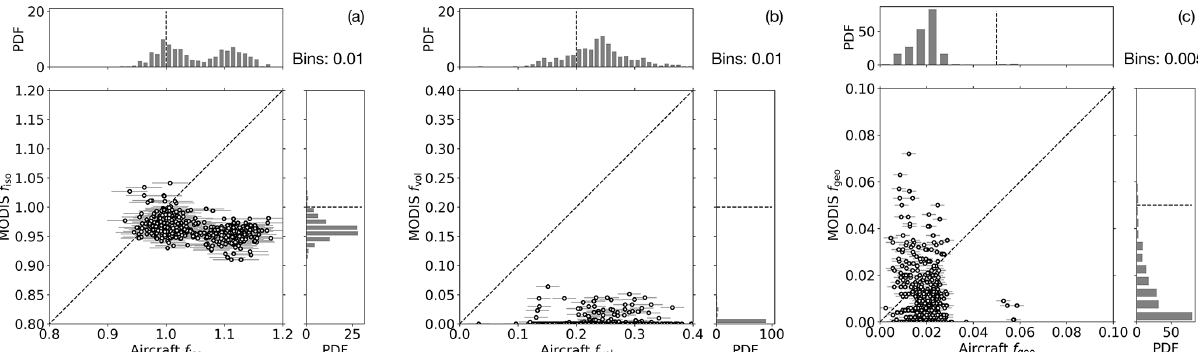
Figure 10. (a) Scatter plot between airborne (490–585nm wavelength) and MODIS (resampled on flight track, 545–565nm) retrieval for f iso including all seven research flights used for the comparison. Error bars correspond to the mean SD of the airborne retrieval. Dashed line: 1 : 1 line. In addition, the histograms for both airborne and satellite retrievals are given. Dashed line: center of axis. (b) As in (a) but for f vol . (c) As in (a) but for f geo